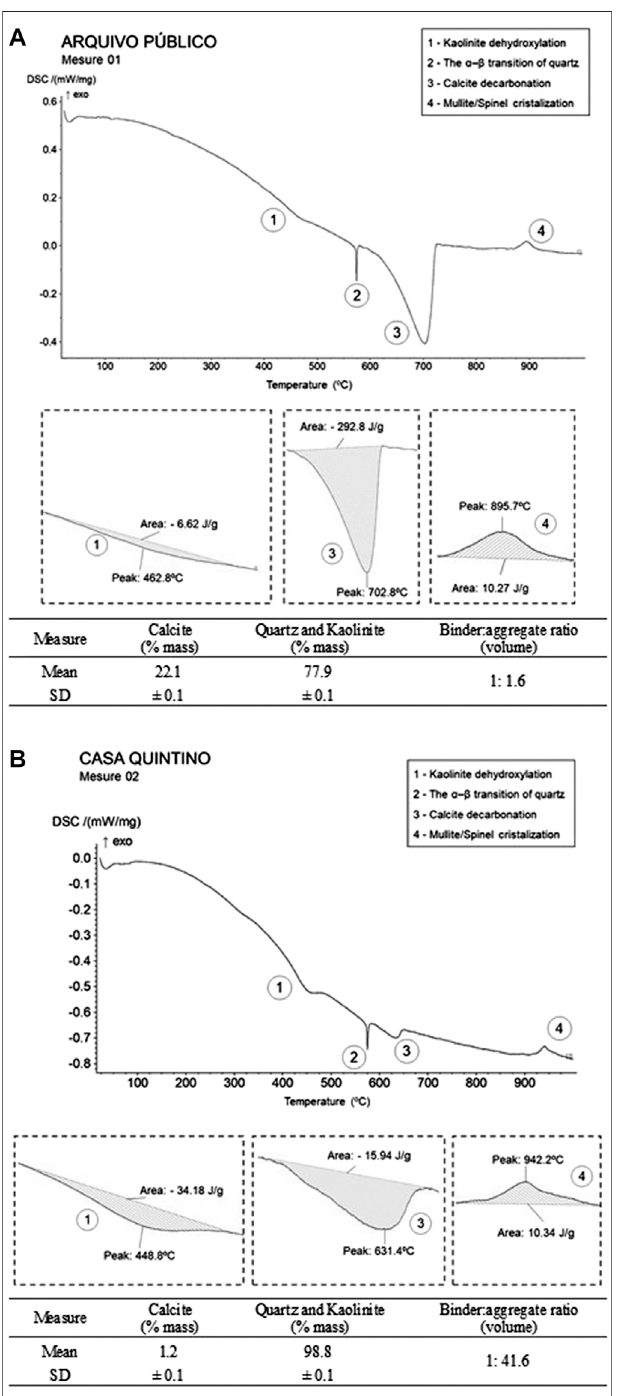
FIGURE 9 | DSC of historic mortars: (A) Arquivo Público and (B) Casa Quintino.